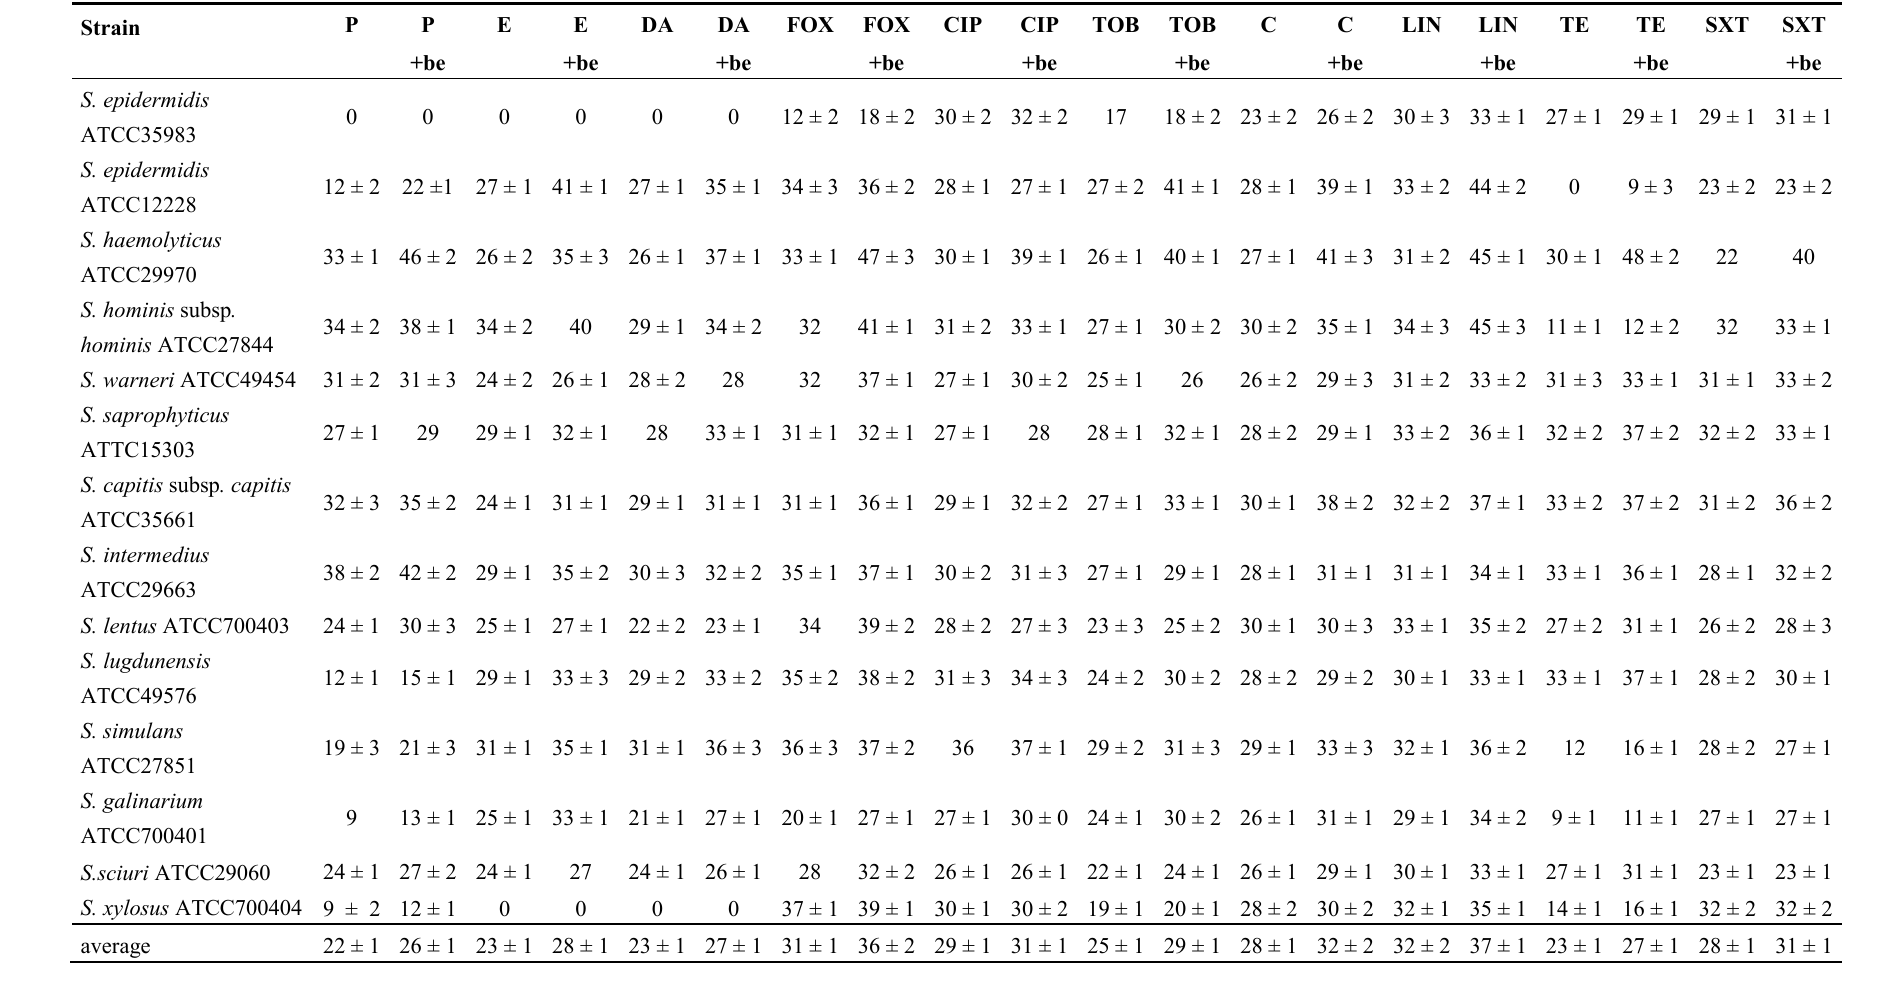
Table 3. The combined antimicrobial effect of antibiotics and berberine towards the reference CoNS staphylococci (mean inhibition growth zones in mm. Values are considered significant at p ≤